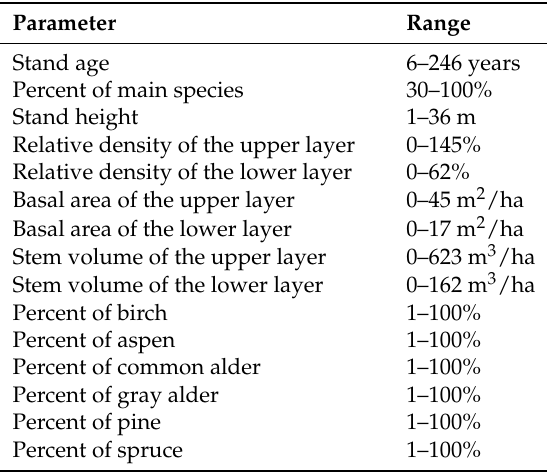
Table 1. The primary forest